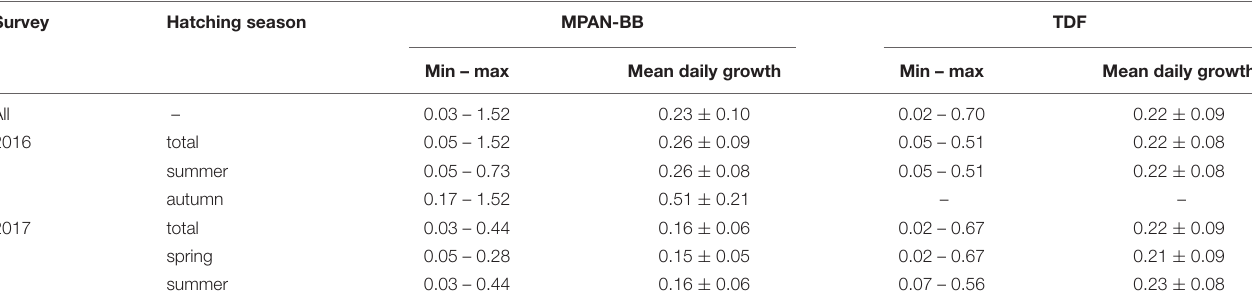
Data used in each analysis is specified according to the factor assessed (habitat, years or hatching seasons). Test statistics for main effects and interactions of the models selected are informed. Asterisks (*) represent significant differences (p-value < 0.05) obtained in the post hoc pair-wise comparison across levels of each factor for equivalent ages.